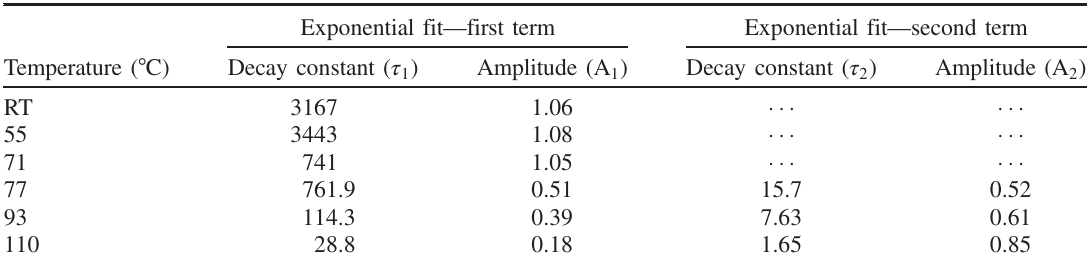
TABLE I. Decay constants and amplitudes from exponential fits with one term and two terms used for different sets of experimental data. The errors of all fitted parameters are within 10%. Exponential fit — first term Exponential fit — second